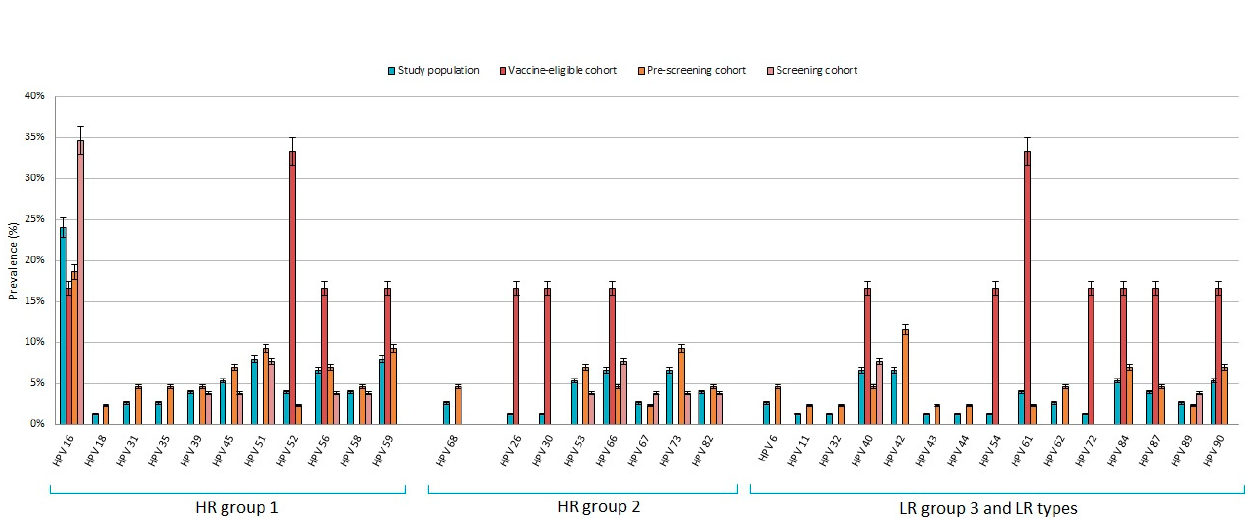
Figure 1. Type-specific prevalence with 95% confidence intervals in urine samples from 393 subjects, broken down by cohorts: vaccine-eligible, pre-screening and screening cohorts. Table 1. Baseline characteristics of patients enrolled from sports medicine centers and universities located in three cities in different Italian Regions: Milan (Lombardy), Genoa (Liguria), and Camerino (Marche) in Northern/Central Italy.